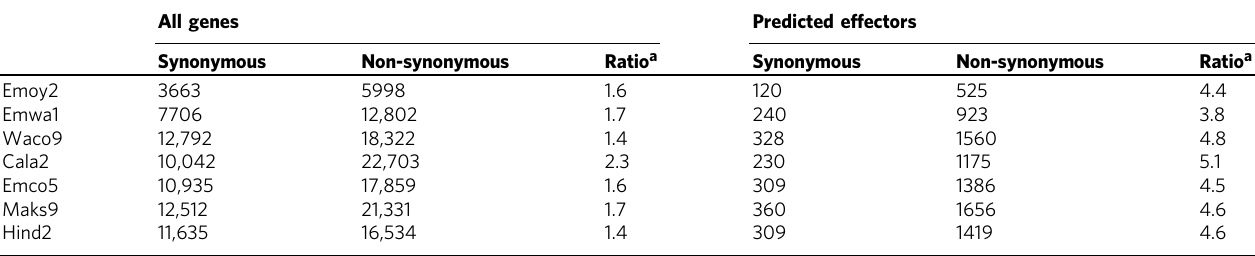
Table 1 Number of synonymous and non-synonymous polymorphisms in Hpa